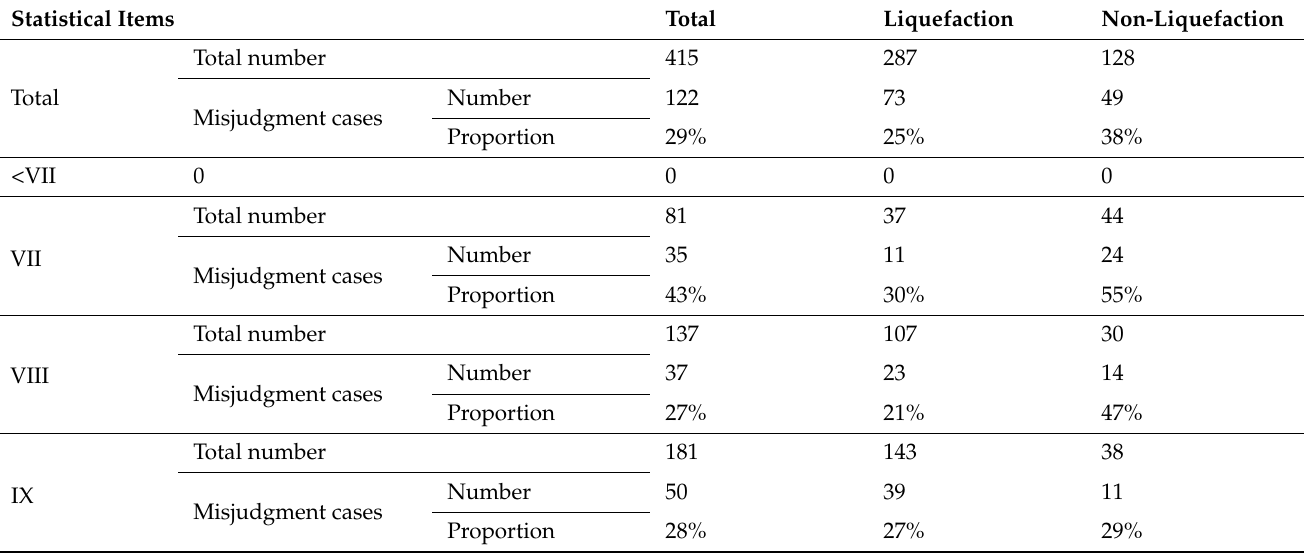
Table 3. Retrieval accuracy of the equation for PL =